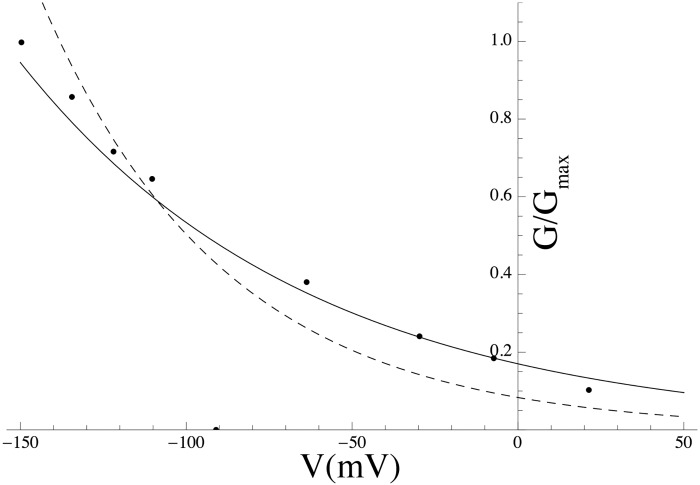
Effect of PIP2 on the Kir7.1 G-V curve.Simulated PIP2 effect on G-V curve (solid line) with data extracted from experiments by Pattnaik et al [56] (solid circles). The G-V curve in the absence of PIP2 (dashed line) is shown for comparison.